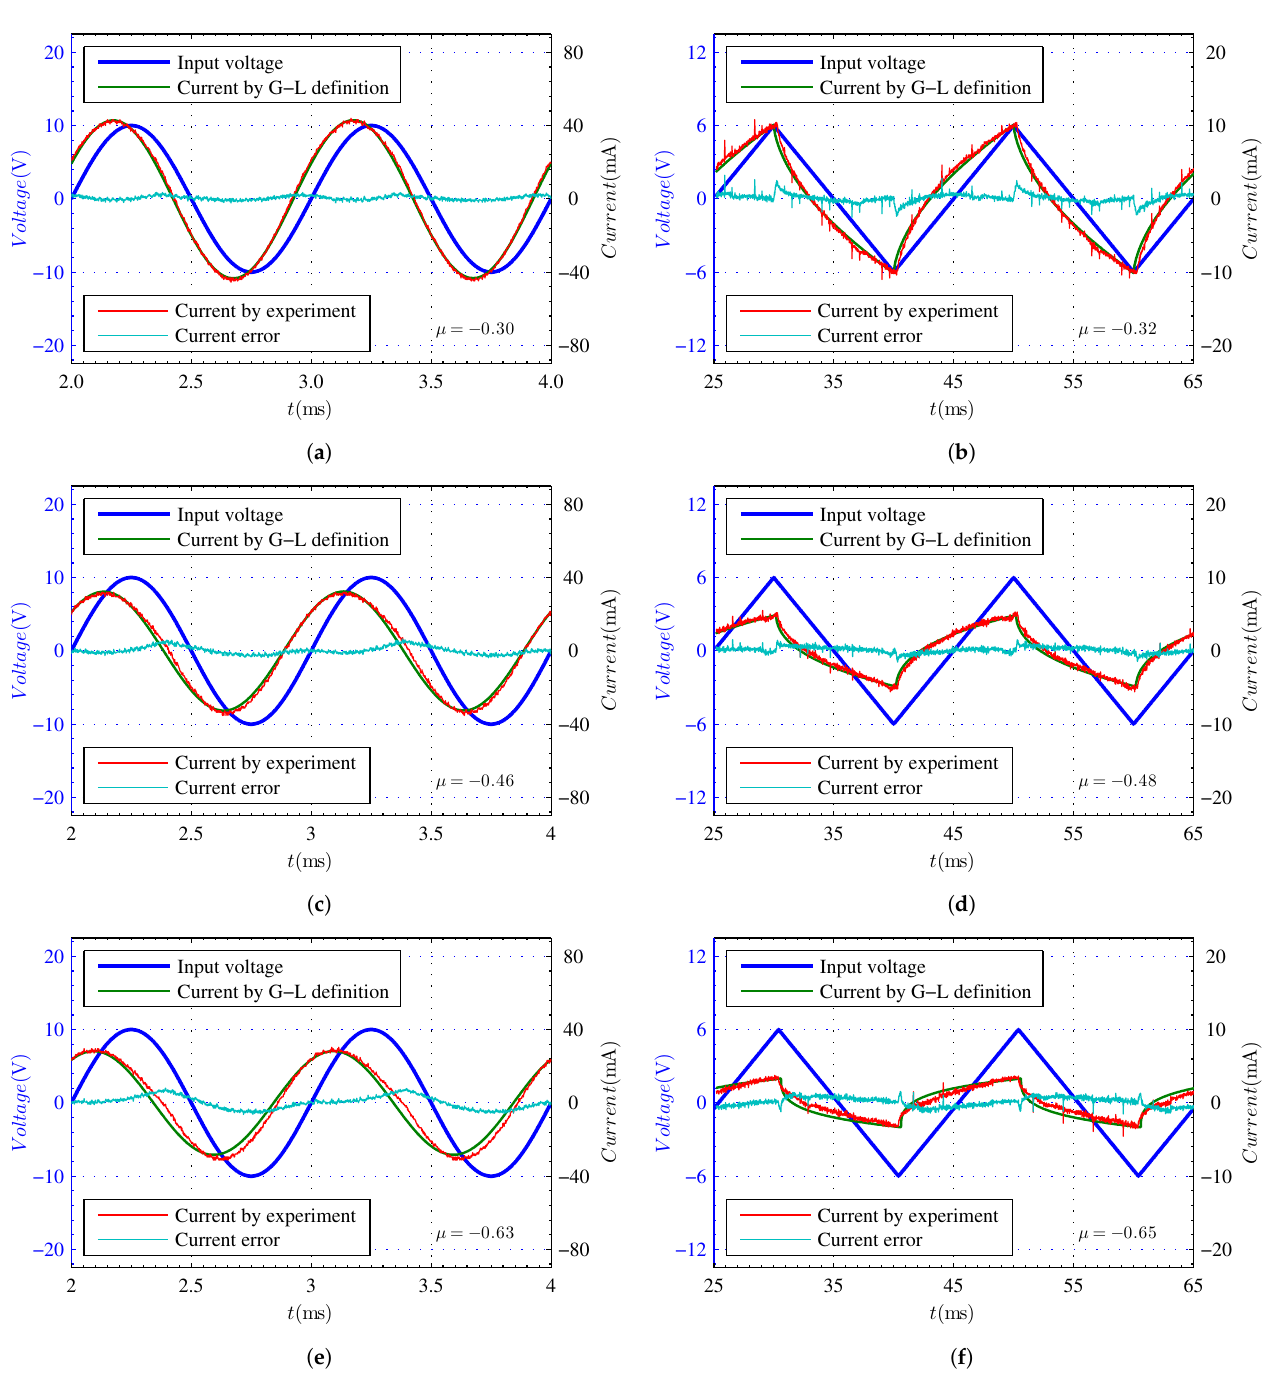
Figure 6. Experimental results of VSFF of steady-state variable-order: ( a ) sine wave, µ = ( b ) triangular wave, µ = 0.32; ( c ) sine wave, µ = 0.46; ( d ) triangular wave, µ = − − wave, µ = 0.63; ( f ) triangular wave, µ = − −